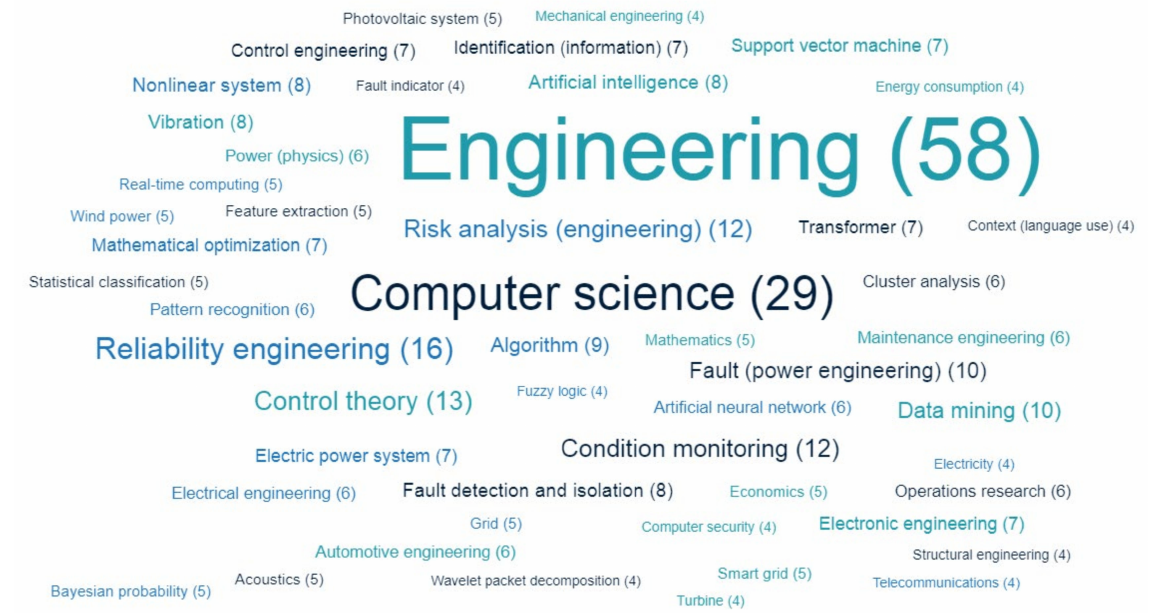
Figure 14. Cloud of top 50 Fields of study in cited scientific